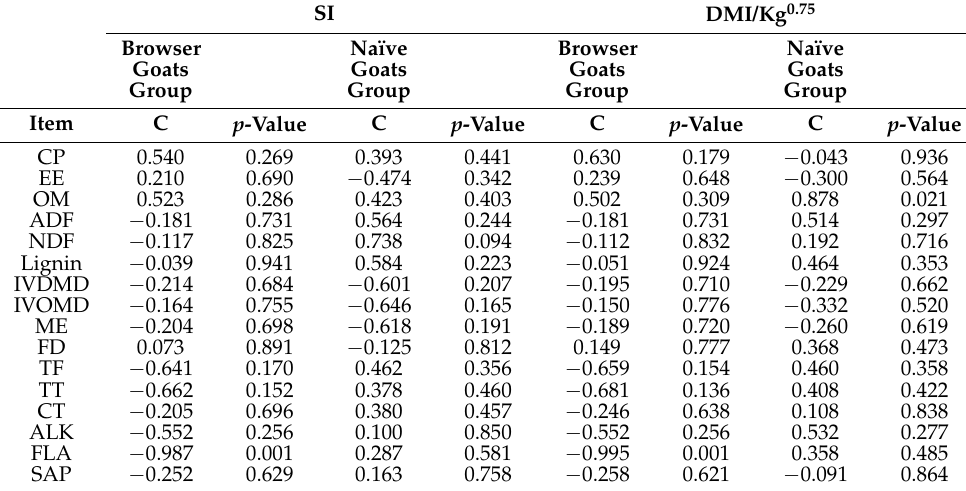
Table 5. Correlation coefficients between chemical composition, secondary compounds content, in vitro dry matter and organic matter digestibility, metabolizable energy, foliage density of six forage resources and selection index (SI) and intake (DMI/Kg 0.75 ) of juvenile goats with (BG) and without (NG) browsing experience during a cafeteria